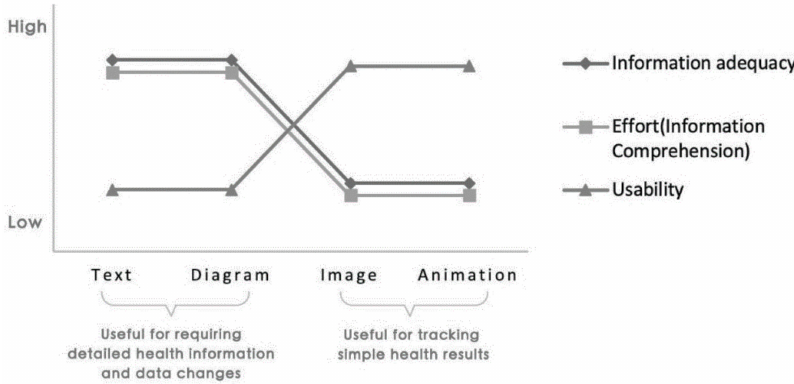
Figure 16. Simple comparison of information comprehension, information adequacy, and usability of the four